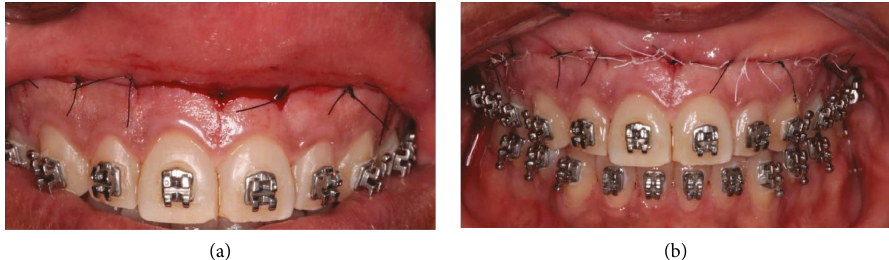
Figure 5: (a) Main external sutures at the height of the center of the papilla. (b) Complementary sutures among the main